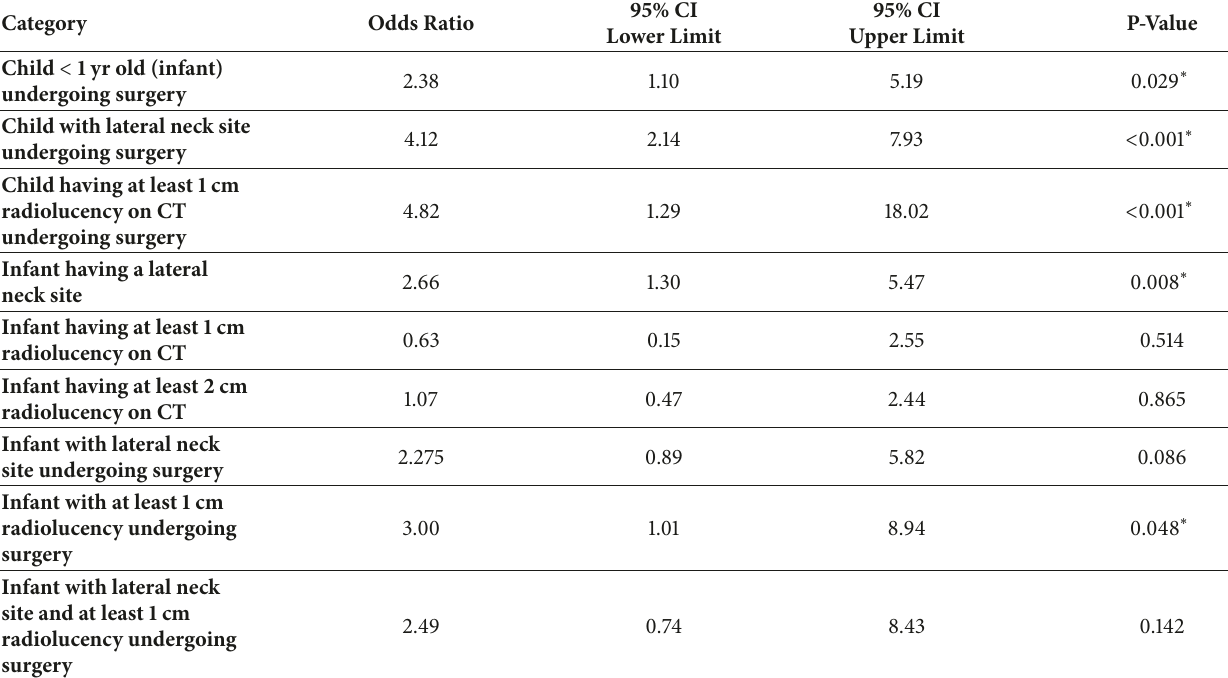
Table 6: Odds ratios and 95% confidence